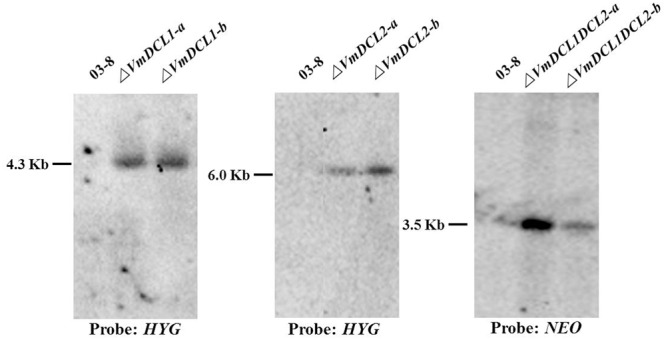
Construction of the VmDCL deletion mutants. Two candidate positive transformants of each mutant (ΔVmDCL1-a and ΔVmDCL1-b; ΔVmDCL2-a and ΔVmDCL2-b; and ΔVmDCL1DCL2-a and ΔVmDCL1DCL2-b) were used for Southern blotting. For ΔVmDCL1, genomic DNA from 03 to 8 and mutants was isolated and digested with restriction enzyme Cla I; for ΔVmDCL2, genomic DNA from 03 to 8 and ΔVmDCL2 was isolated and digested with restriction enzyme Sal I; for ΔVmDCL1DCL2, genomic DNA from 03 to 8 and ΔVmDCL2 was isolated and digested with restriction enzyme Hind III. DNA was hybridized with the probes HYG (ΔVmDCL1 and ΔVmDCL2) and NEO (ΔVmDCL1DCL2).